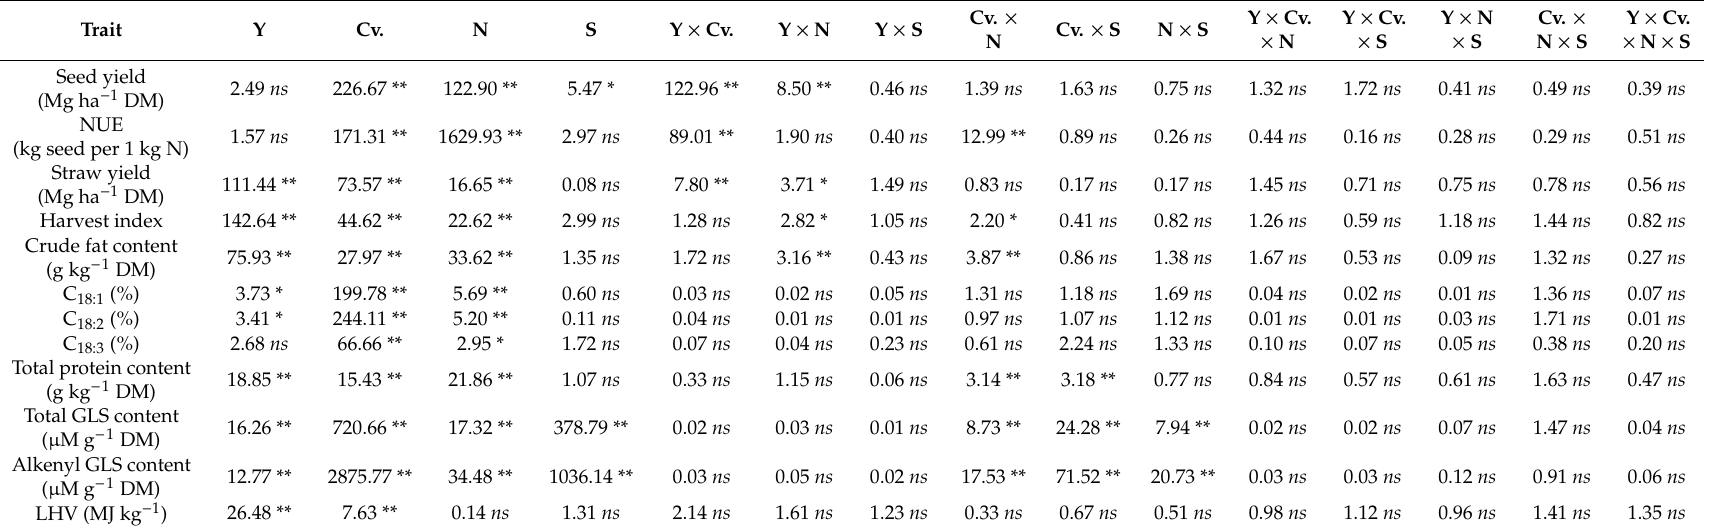
Table 3. F -test statistics in